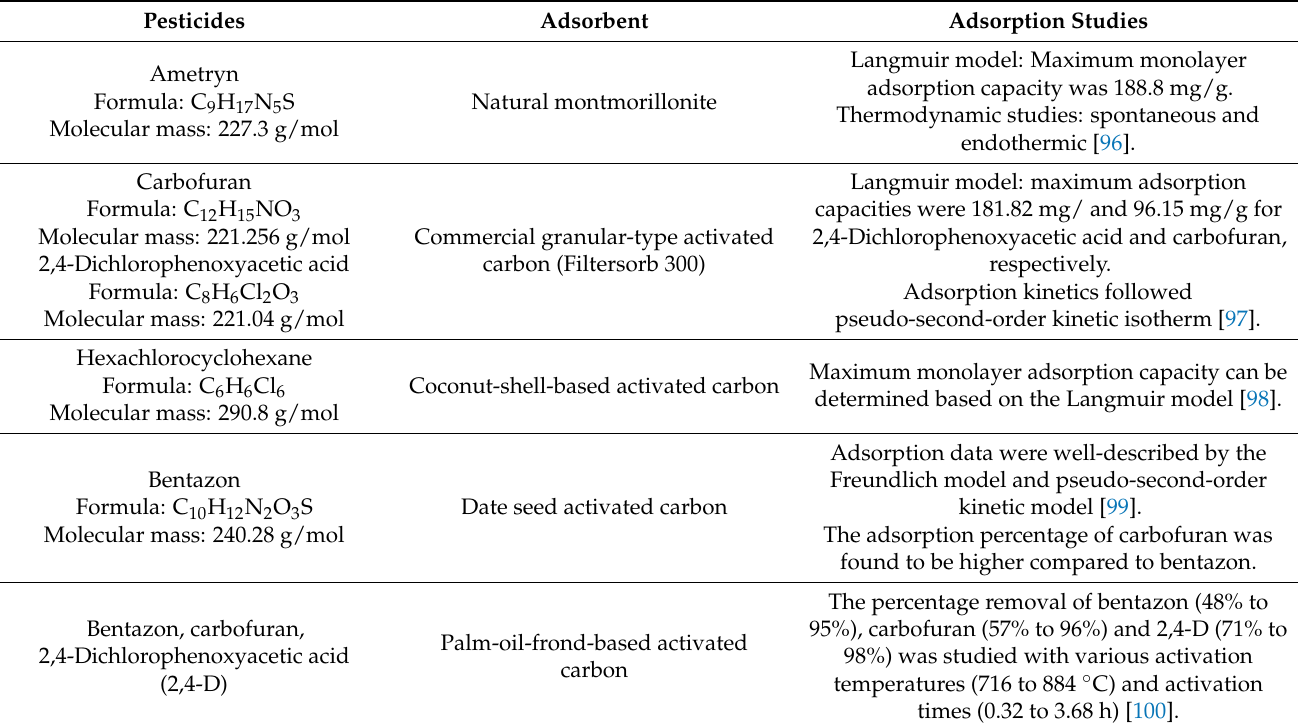
Table 8. Kinetics, isotherms, and thermodynamic studies of the adsorption of pesticides using different